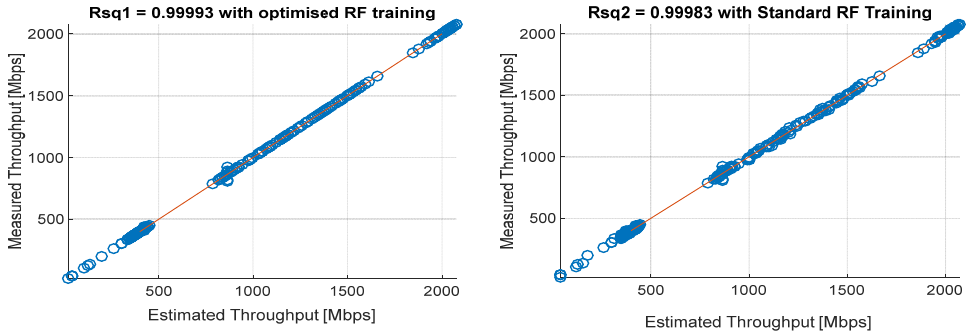
Figure 15. Predicted throughput quality correlation performance of the proposed RF-LS-BPT model and standard RF model at 75 m distance.